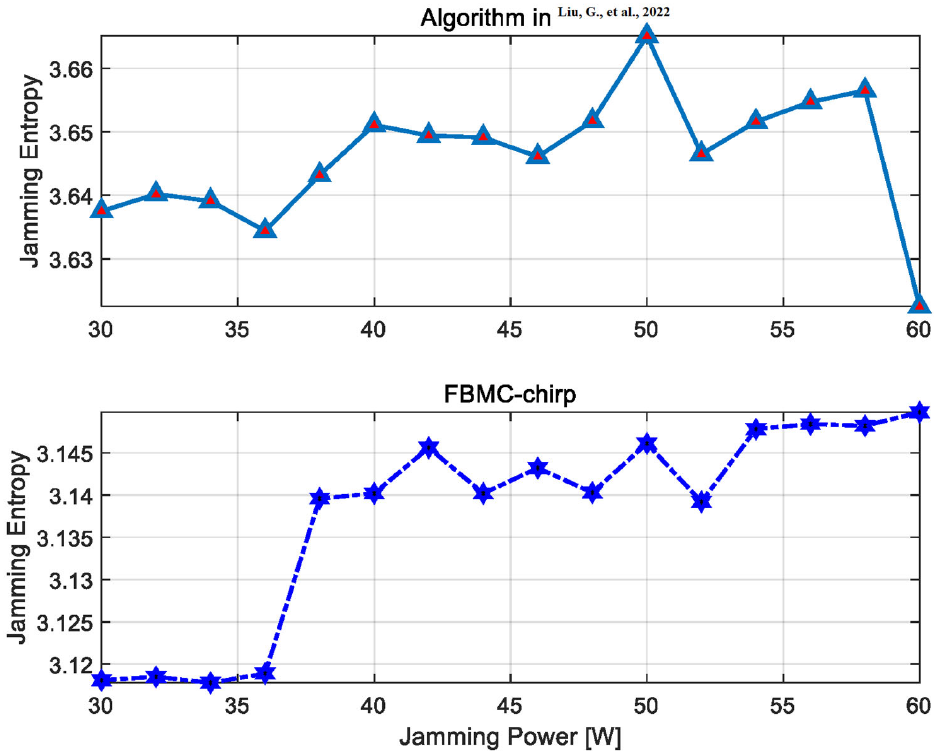
Figure 15. Jamming entropy for the proposed FBMC chirp vs. algorithm in [24]; the number of false targets is 700.